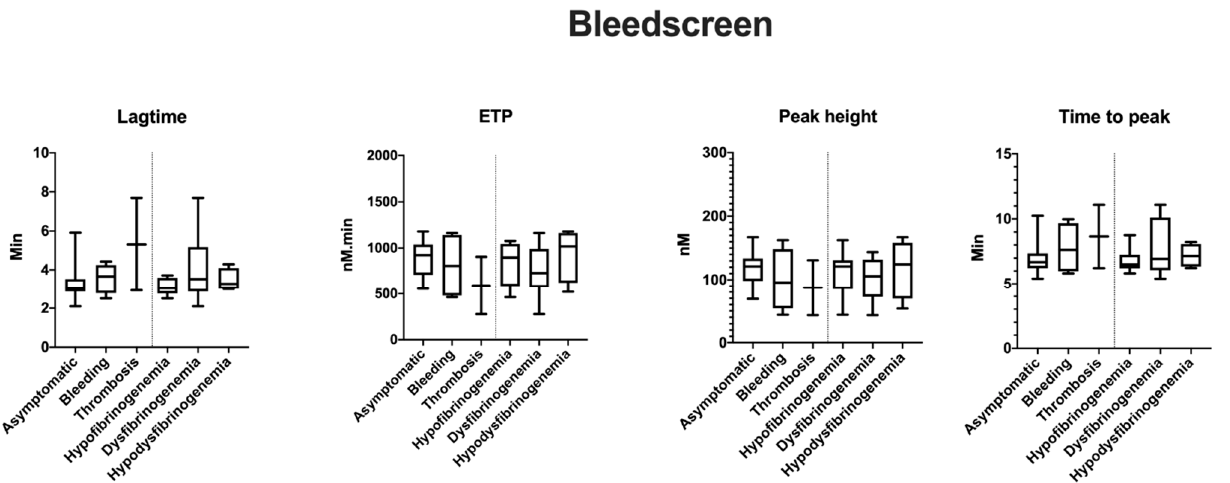
Figure 1. Mean TG variables with STG-BLS (bleedscreen) according to clinical and laboratory phenotypes. TG values are shown for 19 patients as follows: asymptomatic n = 13; bleeding n = 4, thrombosis n = 2; hypofibrinogenemia n = 8; dysfibrinogenemia n = 8 and hypodysfibrinogenemia n = 3.